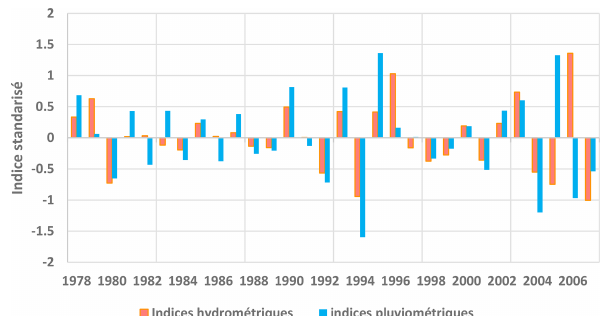
Figure 2. Indices pluviométriques et hydrométriques de 1978 à 2007 pour l’ensemble du bassin versant du Bouregreg (9970km 2